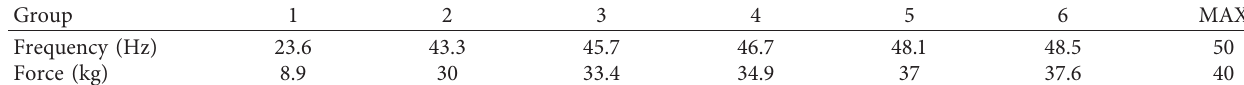
Table 2: Excitation frequency and excitation force.